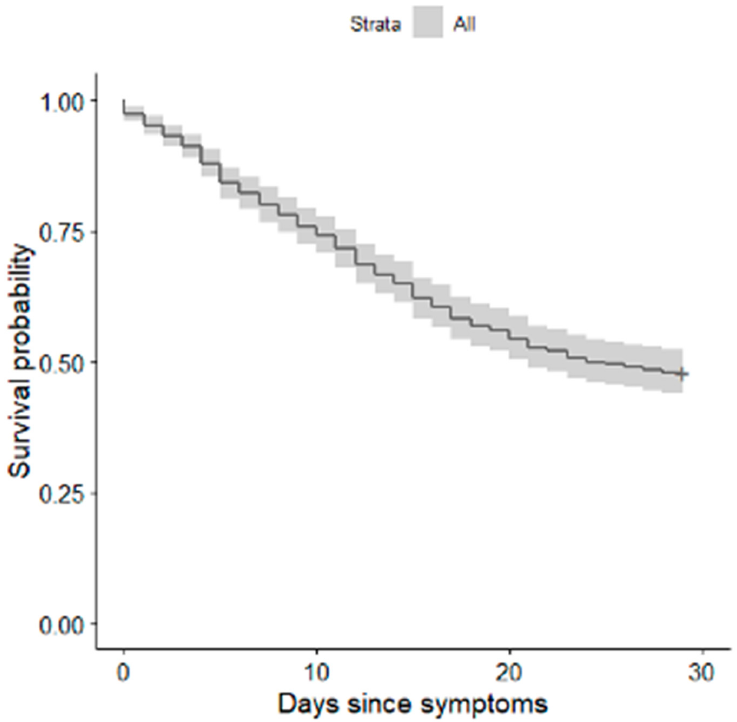
Figure 2. Kaplan–Meier survival plot for 28-day mortality in relation to intubation time. We performed a multivariable Cox model adjusting in 530 patients, because 62 (11.6%) observations were excluded again due to missing data. Among these, 272 patients died. After adjustment for all covariates, the hazard ratio was 1.018 (95% CI, 1.018–1.03) (Figure 3).